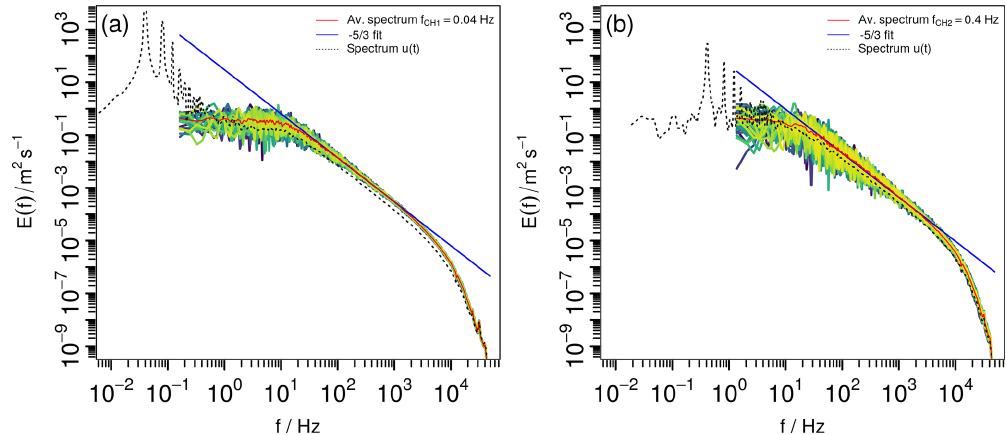
Figure 15. Energy spectral density of all inverse gusts (blue–green–yellow color map) with the average spectrum plotted in red and a decay according to E ( f ) ∝ f − 5 / 3 plotted in blue. The downstream position is X = 5 . 425 w CH , the measurement was carried out at the centerline, = 0 . 4Hz. = 0 . 04Hz and (b) f and the chopper frequency is (a) f CH CH 2 1